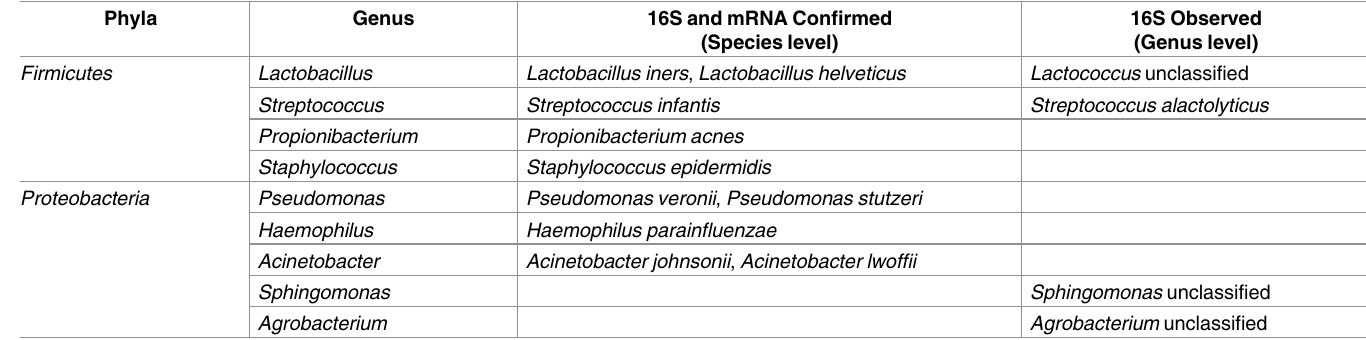
Table 1. Concordantly observed OTU’s. The Proteobacteria and Firmicutes species which were concordantly observed in the 16S-RNAgene and mRNA sequencing data. Additional 16S read data were observed, yet remained uncharacterized at the species level, which could coincidewith mRNA observations. Phyla Genus 16S and mRNA Confirmed 16S Observed (Species level) (Genus